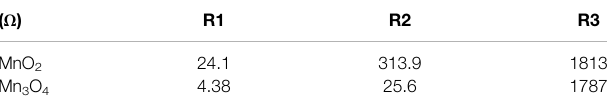
TABLE 1 | EIS fi tting result of textile ZIB with MnO 2 and Mn 3 O 4